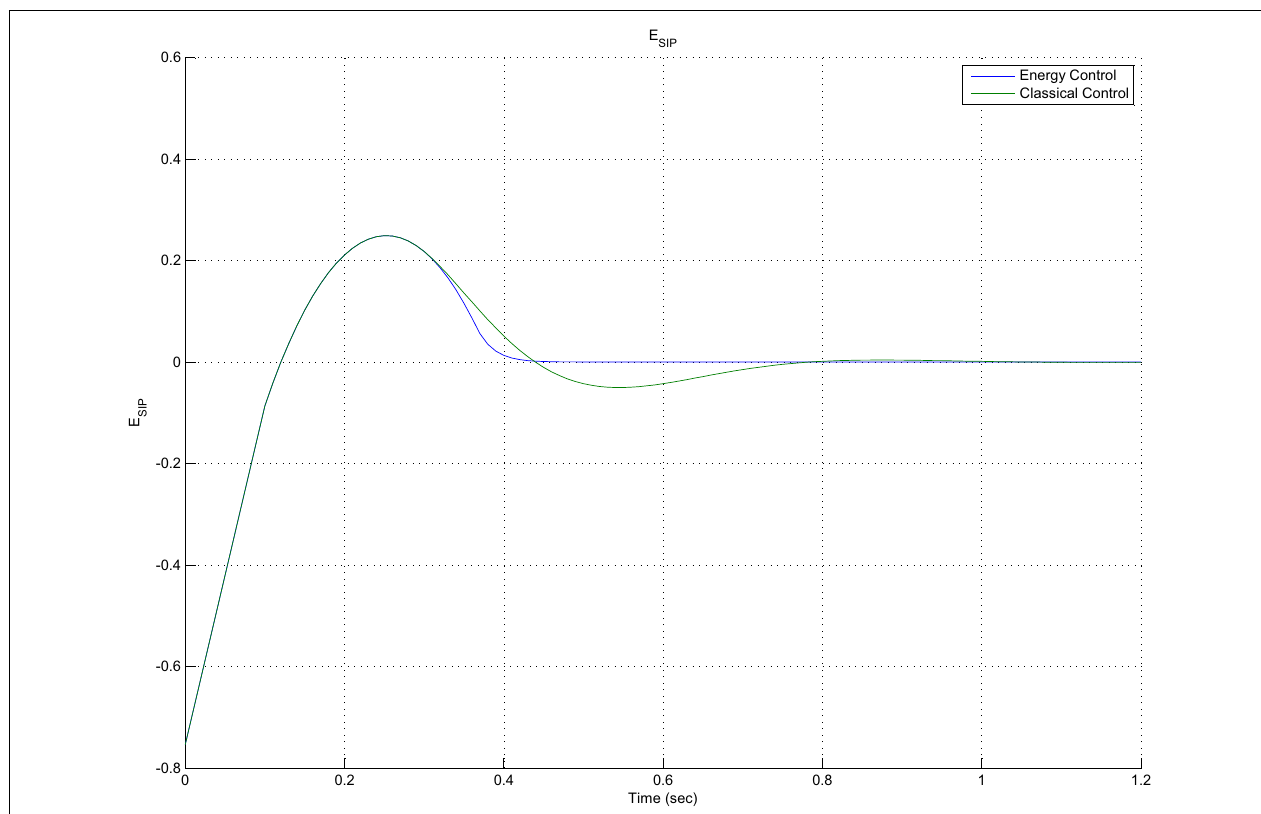
FIGURE 5 | Comparison between the TME change using energy-based controller vs. standard controller